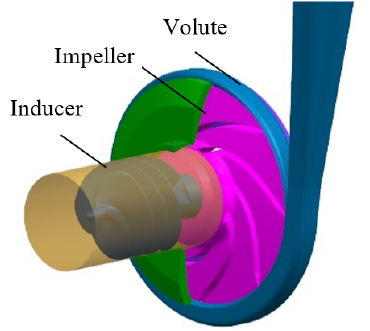
Figure 1. Computational domain of the centrifugal pump.